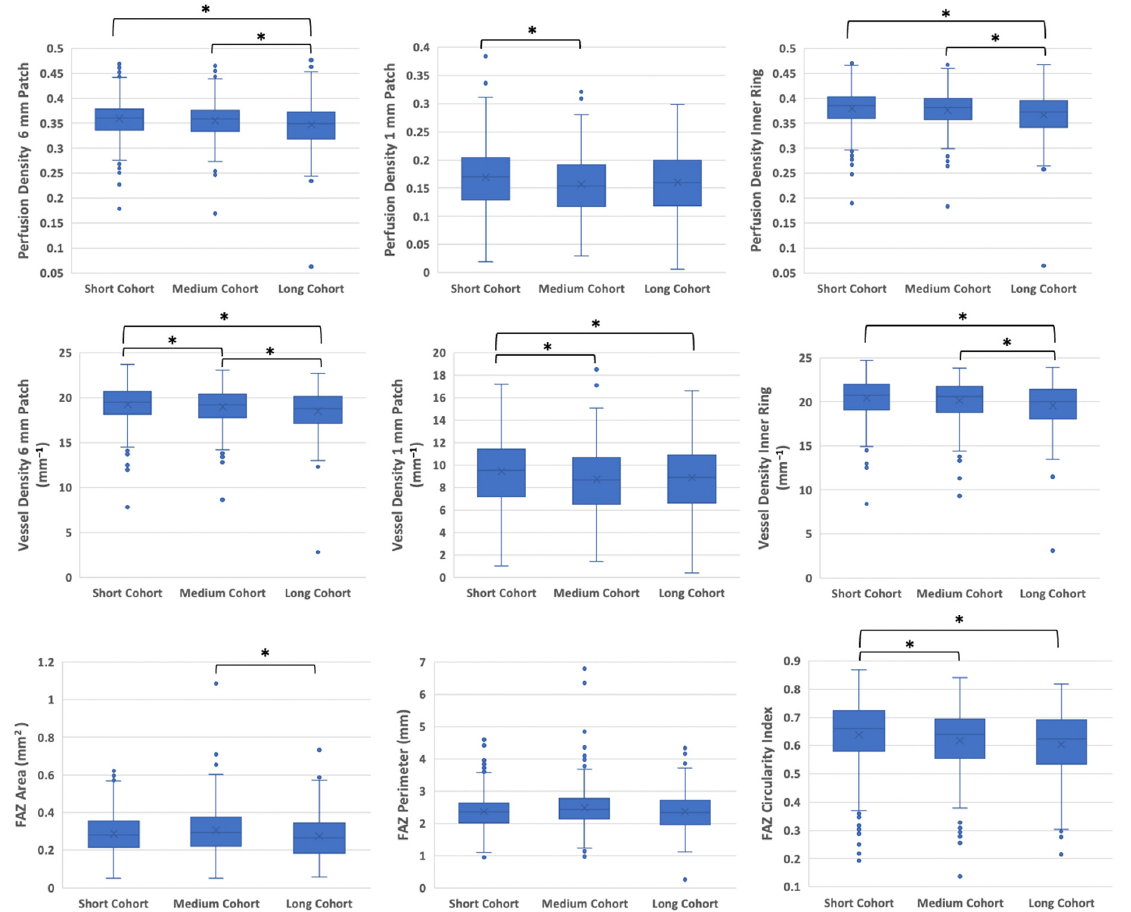
Figure 2. Graphs of density and foveal avascular zone metrics in the superficial capillary plexus (SCP) for the three diabetes duration groups. Boxes represent the interquartile range in each group. * p < 0.05.